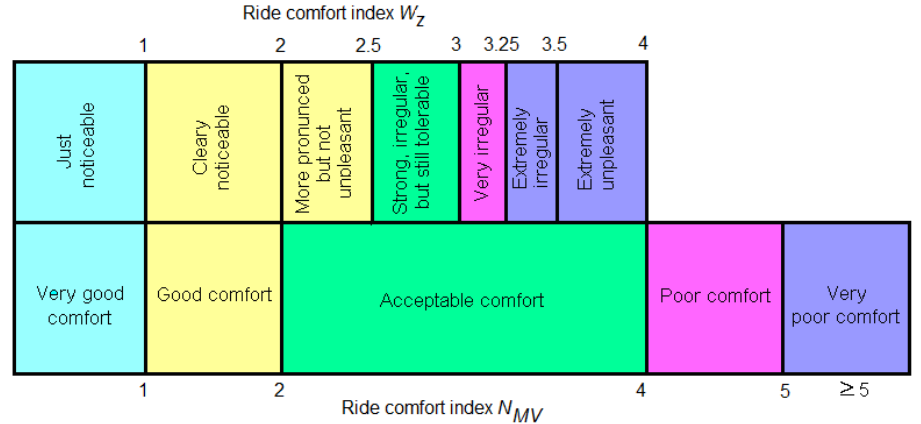
Figure 5. Correlation between ride comfort index N MV and ride comfort index W z .